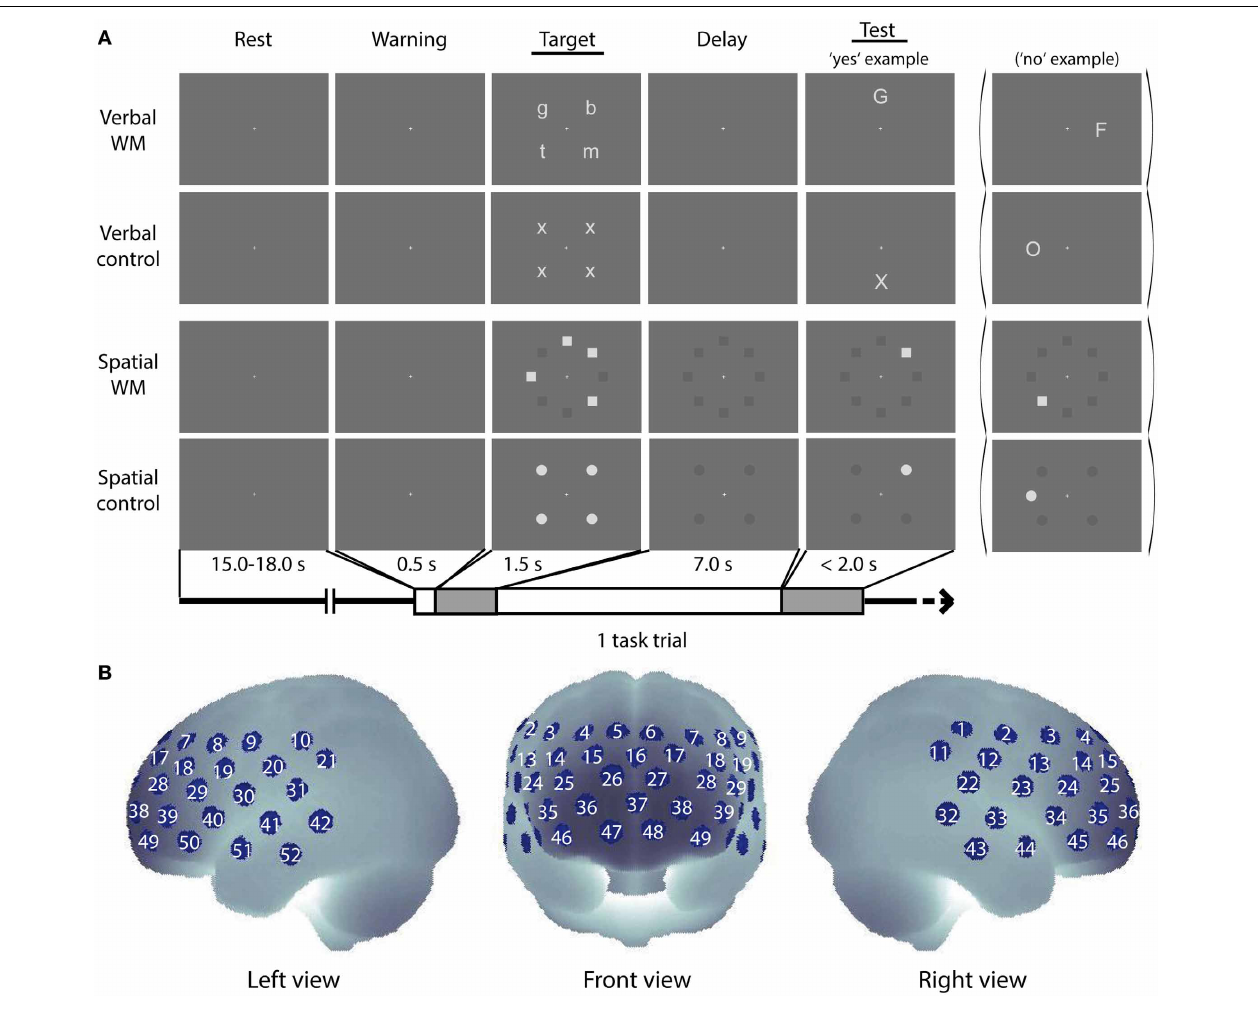
FIGURE 1 | Cognitive tasks and NIRS measurement positions. (A) Schematic diagram of a task trial sequence. Example images for the verbal WM task, the control task for verbal WM, the spatial WM task, and the control